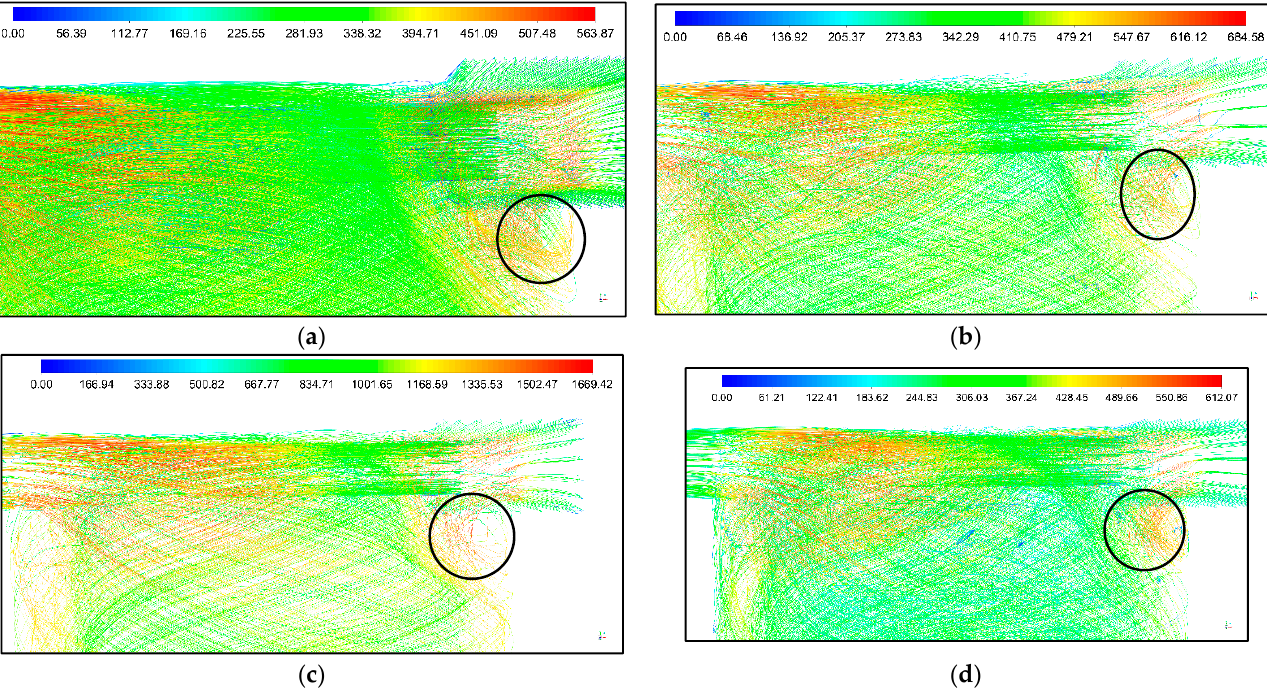
Figure 9. Velocity streamlines obtained for SVT with ( a ) Ar ; ( b ) air ; ( c ) He ; and ( d ) CO 2 . The secondary swirl is understood as the rotation of the flow relative to its main direction (Figure 10). In Figure 10, V s is flow velocity along the main direction (streamlines from Figure 9), and V θ is rotation velocity relative to the main direction.